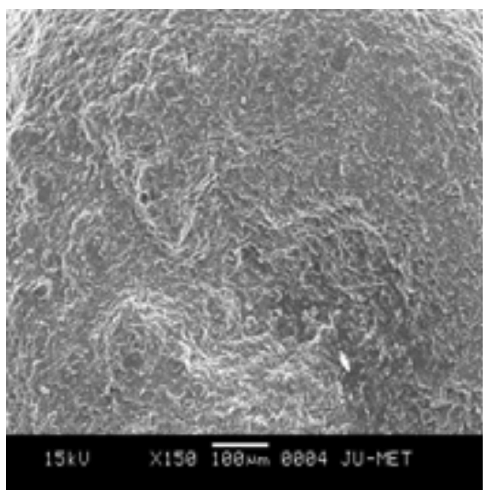
FIGURE 1 (c) - SEM photograph of only alginate beads (F1).